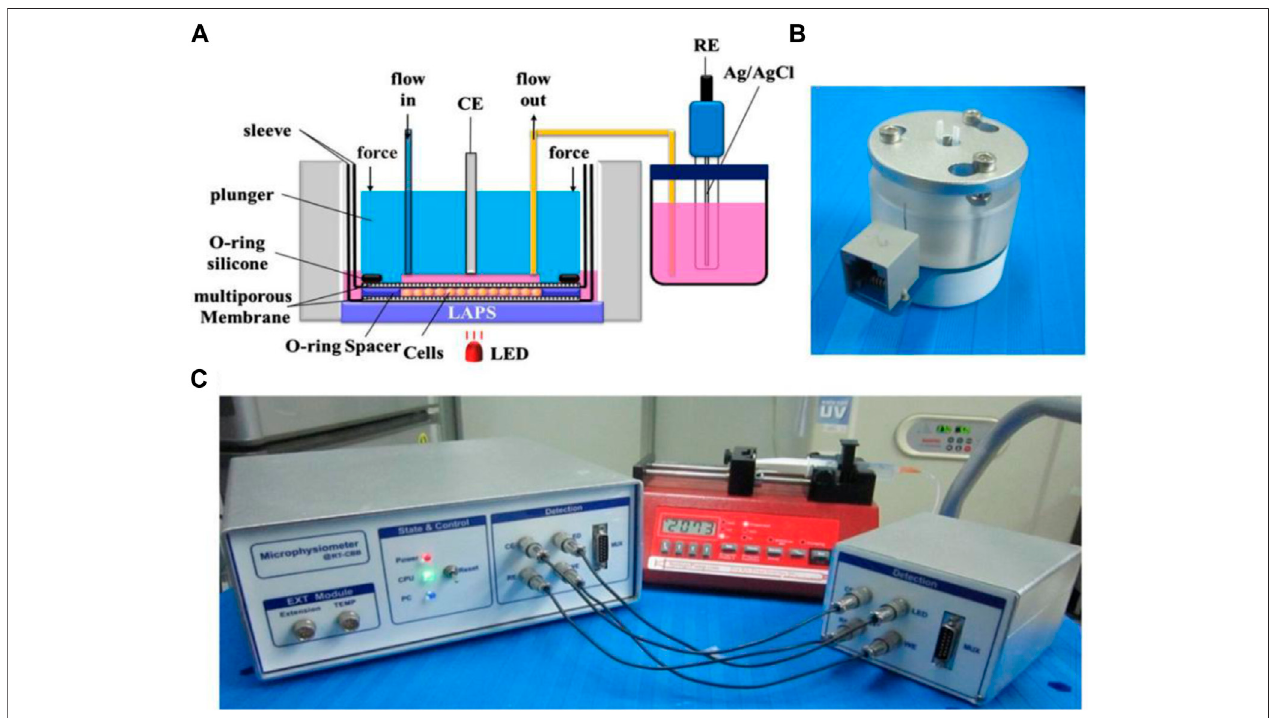
FIGURE5|(A) SchematicstructuraldiagramofcellmicrophysiologybasedontheLAPS (B) Microphysiometer fl uiddriveunit; (C) Schematicdiagramoftheoverall structure of the detection system (Hu et al., 2013).